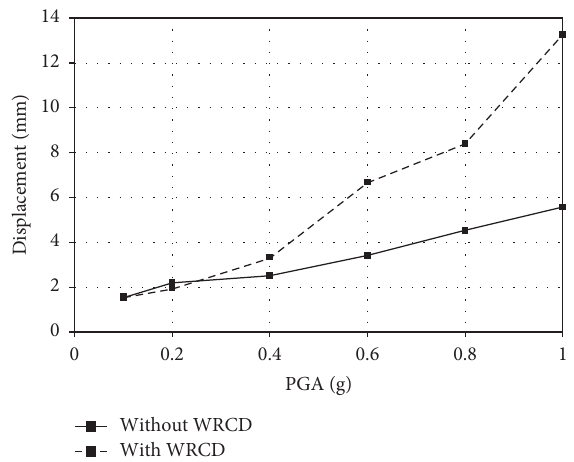
Figure 14: Te maximum displacement of 3# sliding pier top.